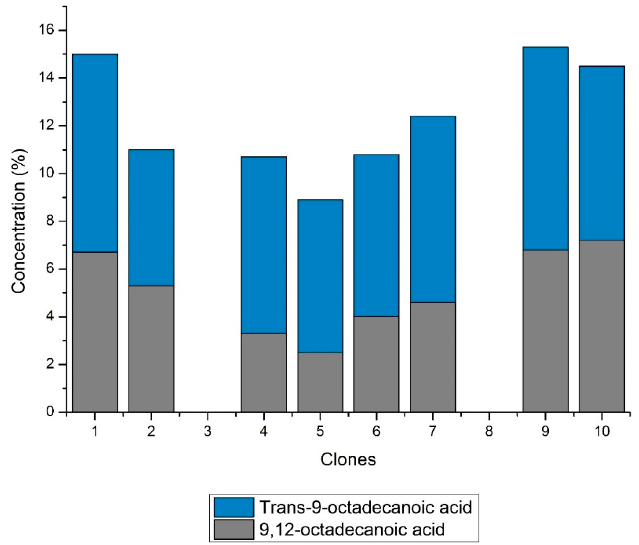
Figure 7. Substituted alkanoic acid content of Eucalyptus spp. identified in lipophilic dichloro- methane extracts.